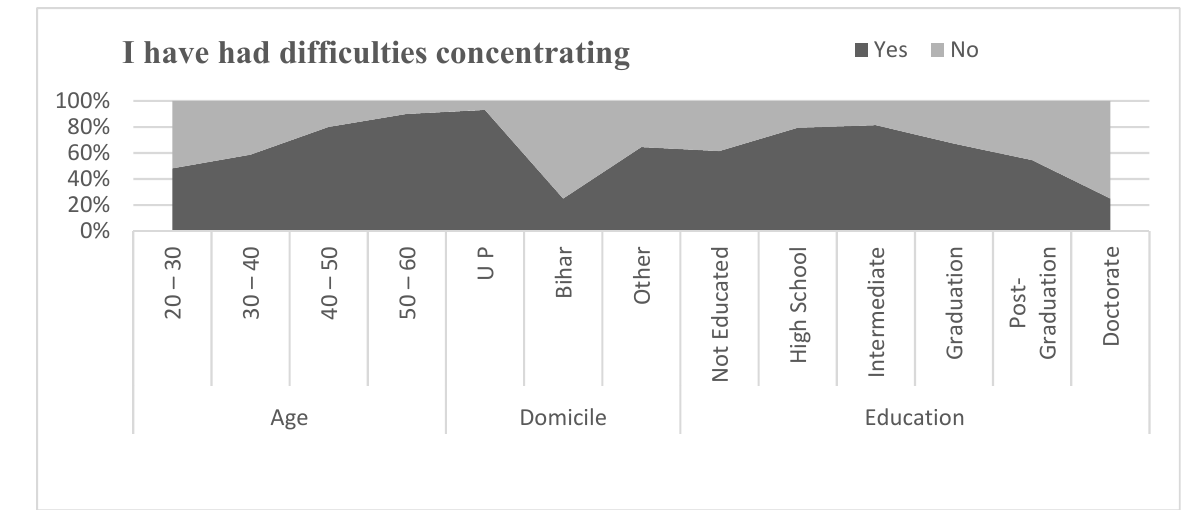
Figure 7. Comparison of hard time sleeping.